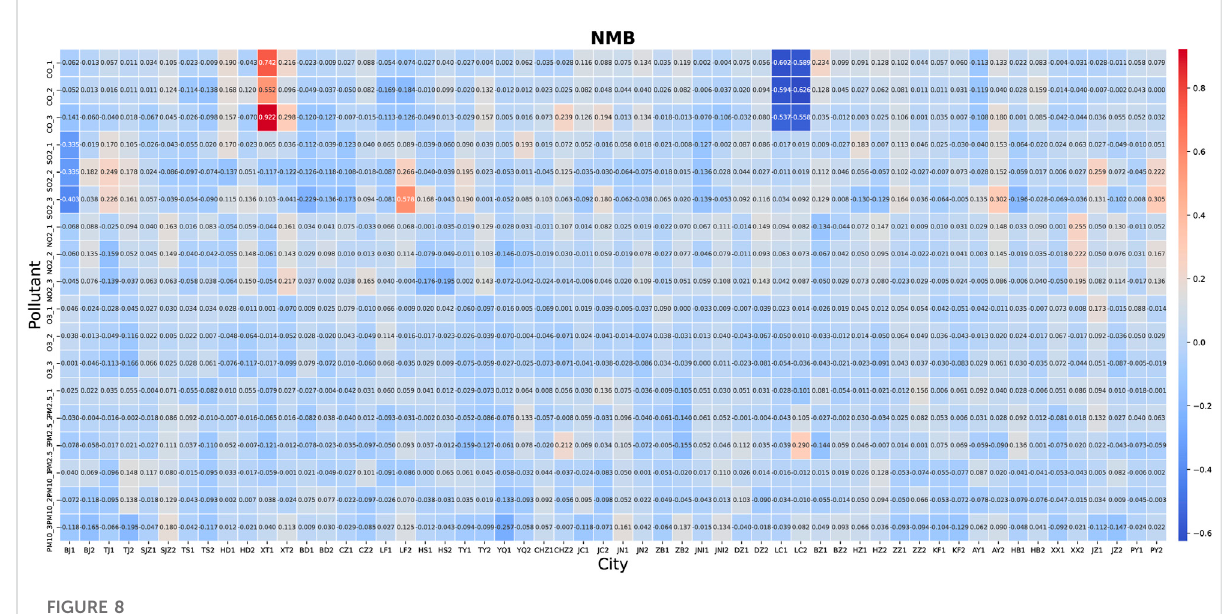
FIGURE 8 The NMB of pollutant concentration prediction of TSTM in “ 2+26 ” cities.